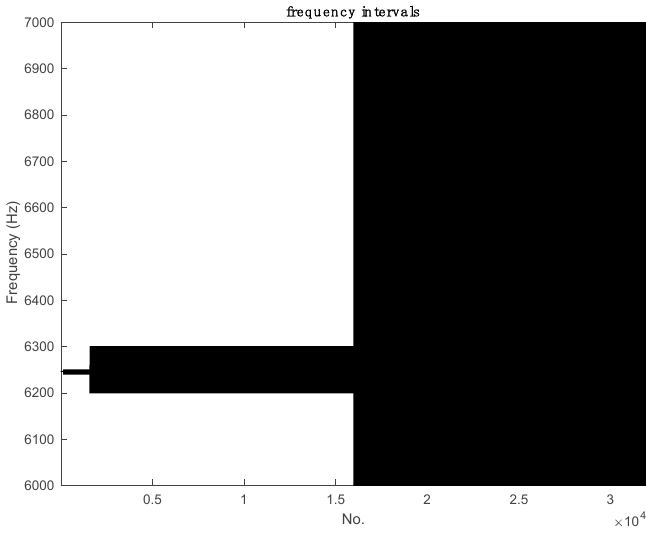
Figure 5. Frequency interval changes in one test.